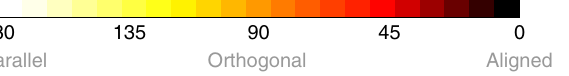
Fig. 5 Fluid-like thermal transport in room-temperature solid